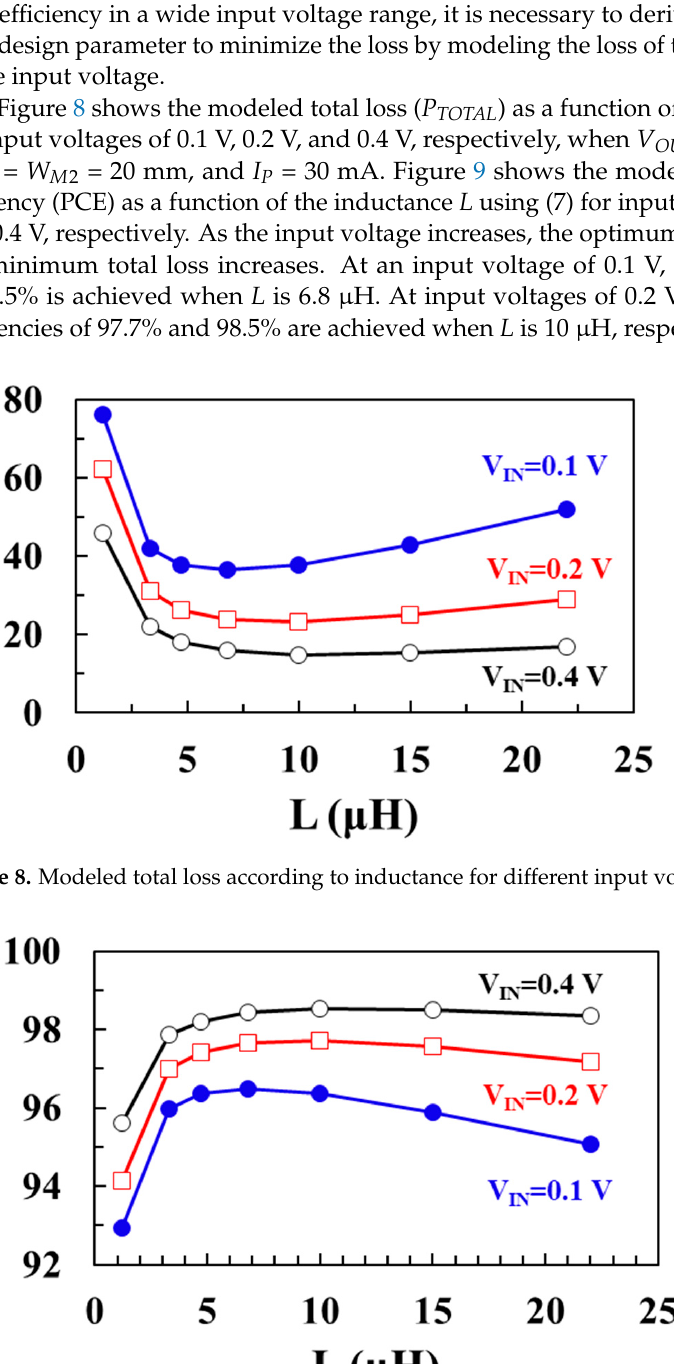
Figure 7. Schematic of the DC-DC boost converter with the control circuits.